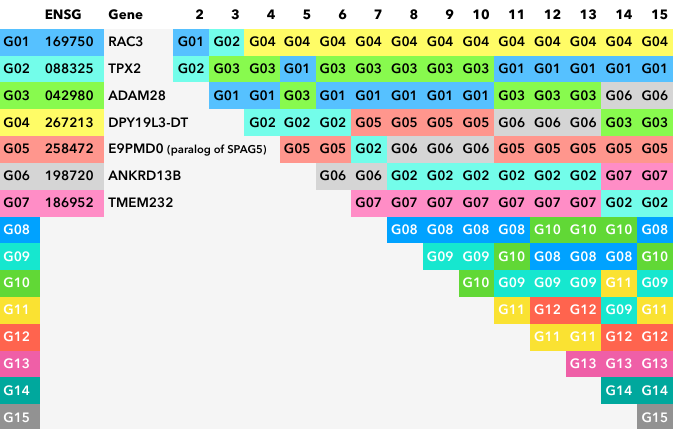
Figure 5. Most-representative markers at different clustering levels in 150 repeats of hierarchical clustering procedure. The first 3 columns show the order in which markers are included in the representative set, when the number of representatives is increased by 1—from 2 to 15. The Ensemble code of each marker, with 5 leading zeros removed, is shown in column 2, and the gene name corresponding to the marker is shown in column 3. In the remaining columns, the markers that are most often selected as representatives in 150 repeats are shown, and their positions within the column corresponds to the frequency of selection of a given marker as the representative (higher position—higher frequency).